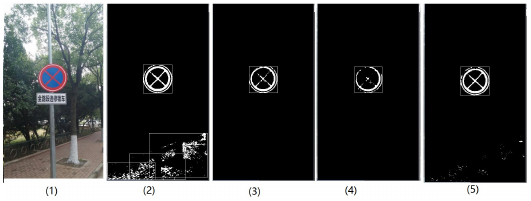
Figure 16: Different RGB Threshold Results